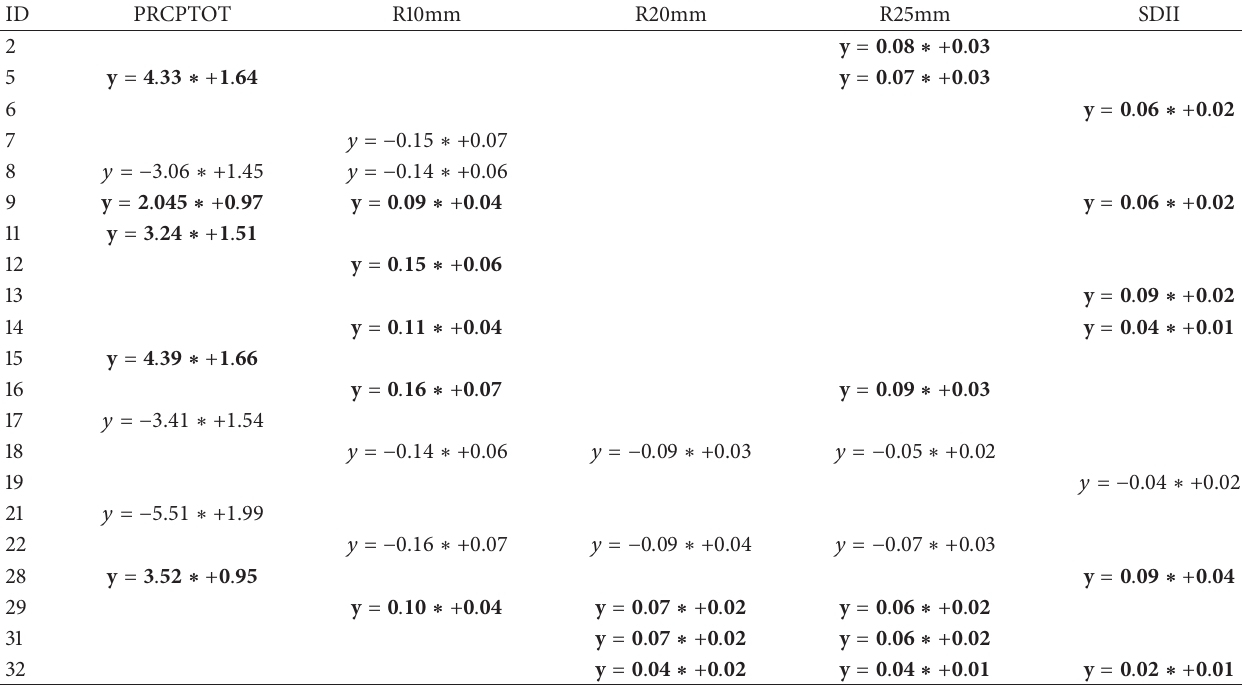
Table 3: Significant trend line equations of precipitation-based indices by ground-weather stations; table includes only all the stations with significant 𝑃 < 0.05 for at least one index. Bold numbers indicate a positive trend and normal text a negative trend; empty cells were nonsignificant ( 𝑃 > 0.05